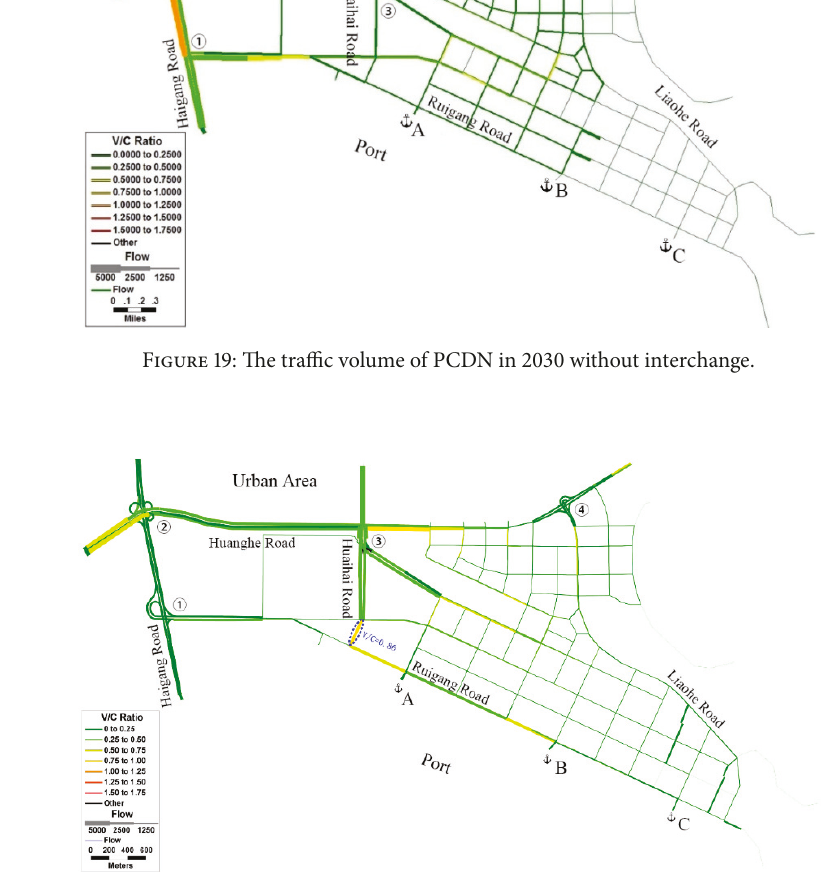
Figure 20: The traffic volume of PCDN in 2030 with one